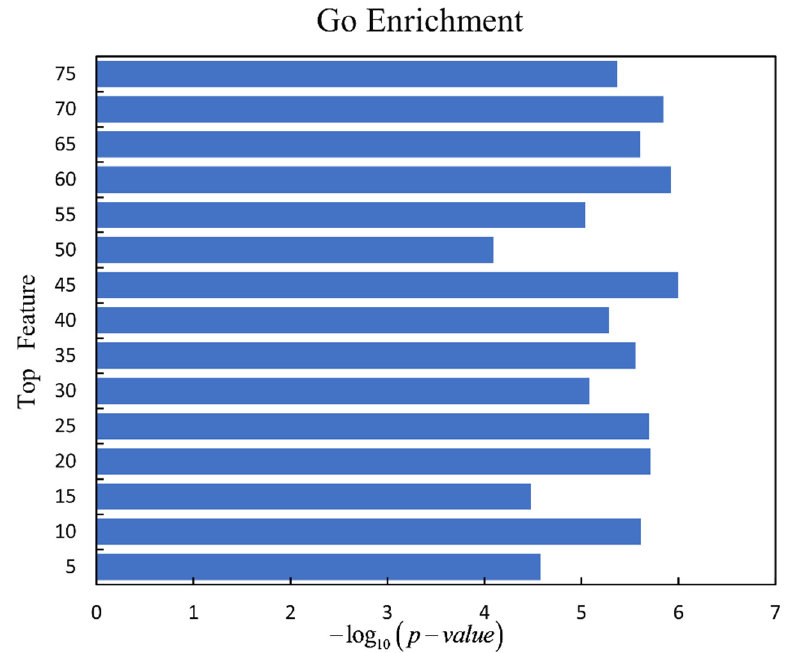
Figure 6. Enrichment of the driver gene sets predicted by the top N features using GSEA.